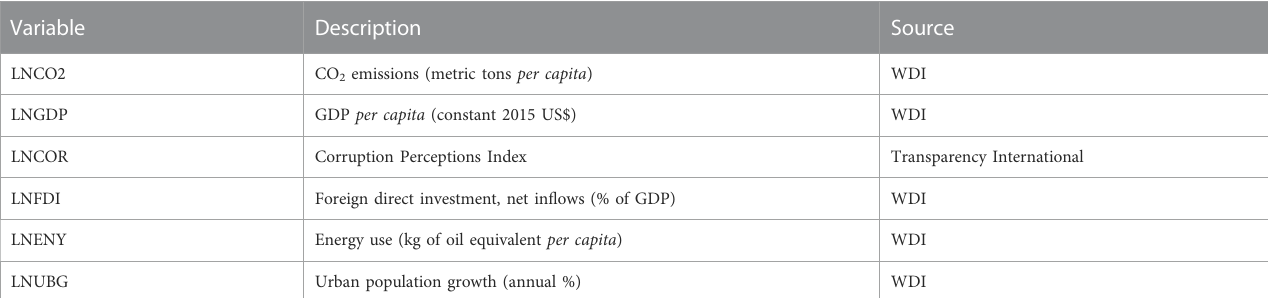
TABLE 2 Sources of data.